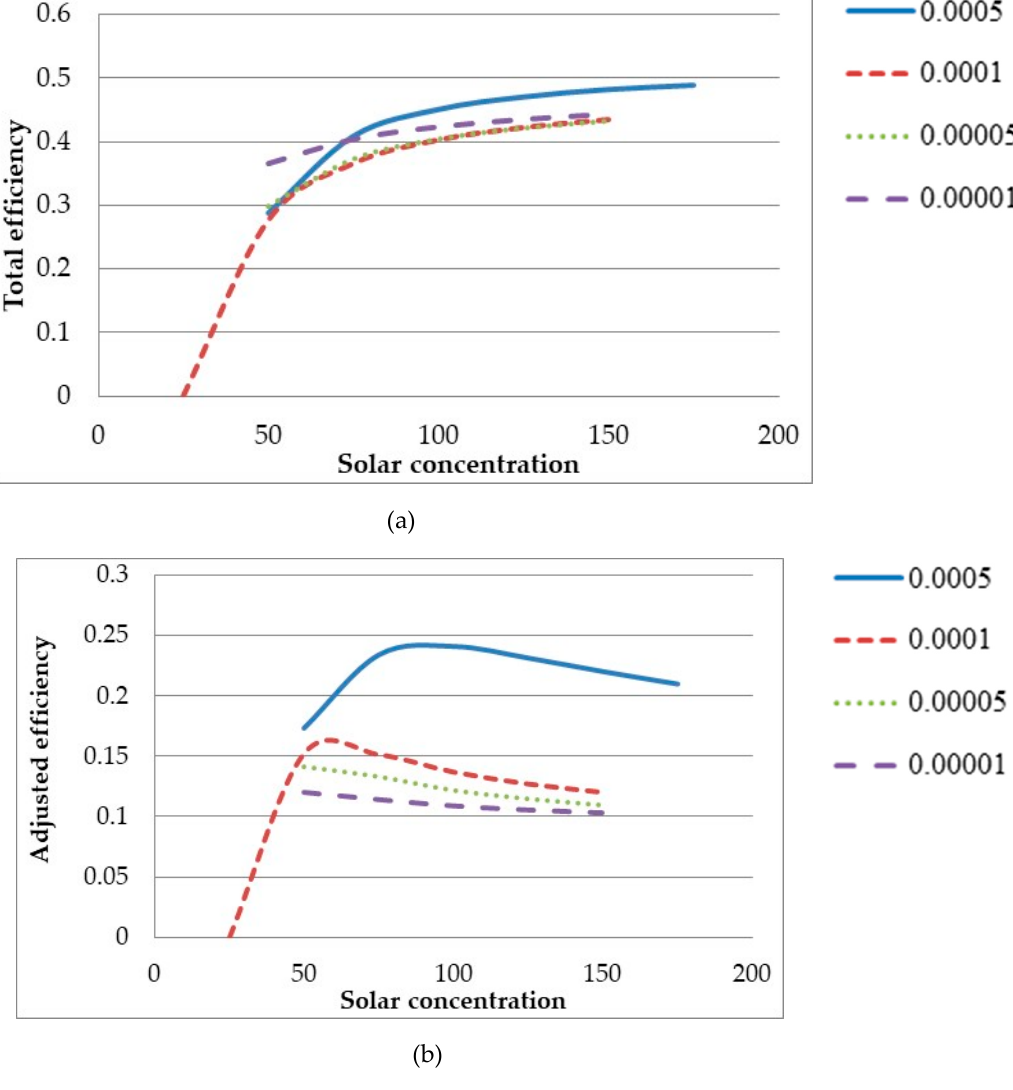
Figure 22. Solar concentration comparison at different volume fractions: ( a ) the total efficiency and ( b ) the adjusted efficiency (The legend at the right side of the figure shows the volume fractions).